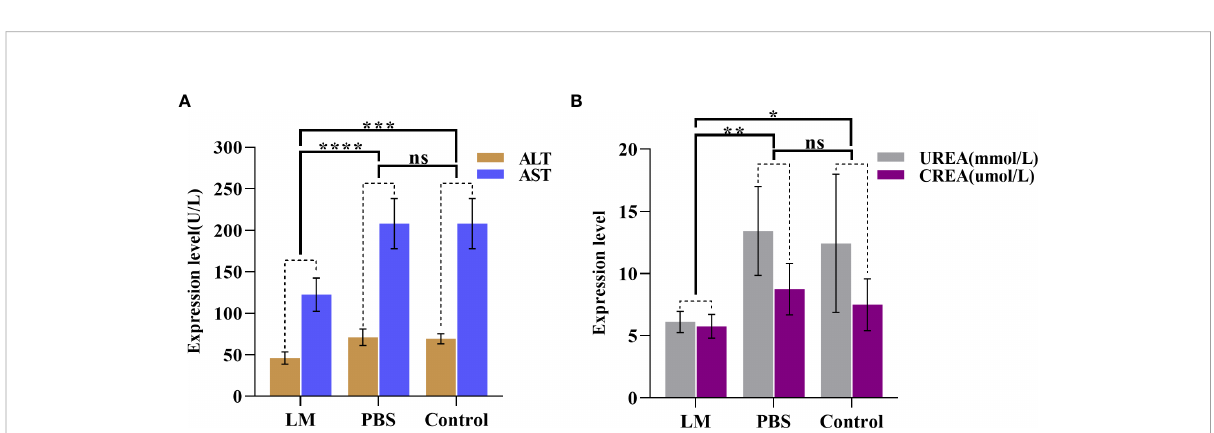
FIGURE 7 The statistical results of group comparison in serum biochemical tests. (A) The expression level of AST and ALT in in three groups. (B) The expression level of UREA and CREA in in three groups. LM, liquid metal; PBS, phosphate buffer saline; ALT, Alanine aminotransferase; AST, Aspartate aminotransferase; CREA, creatinine; UREA, carbamide; *, indicates P<0.05; **, indicates P<0.01; ***, indicates P<0.001; ****, indicates P<0.0001, “ ns ” indicates no signi fi cant differences.